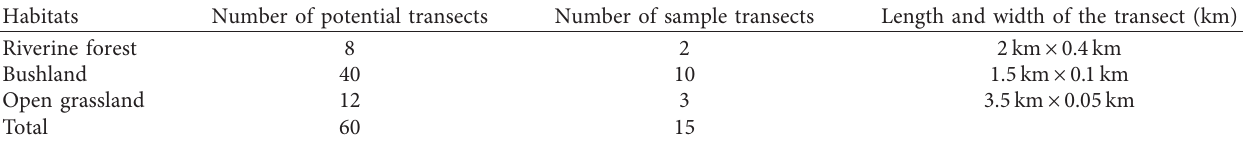
Table 1: Length and width for randomly selected transects.